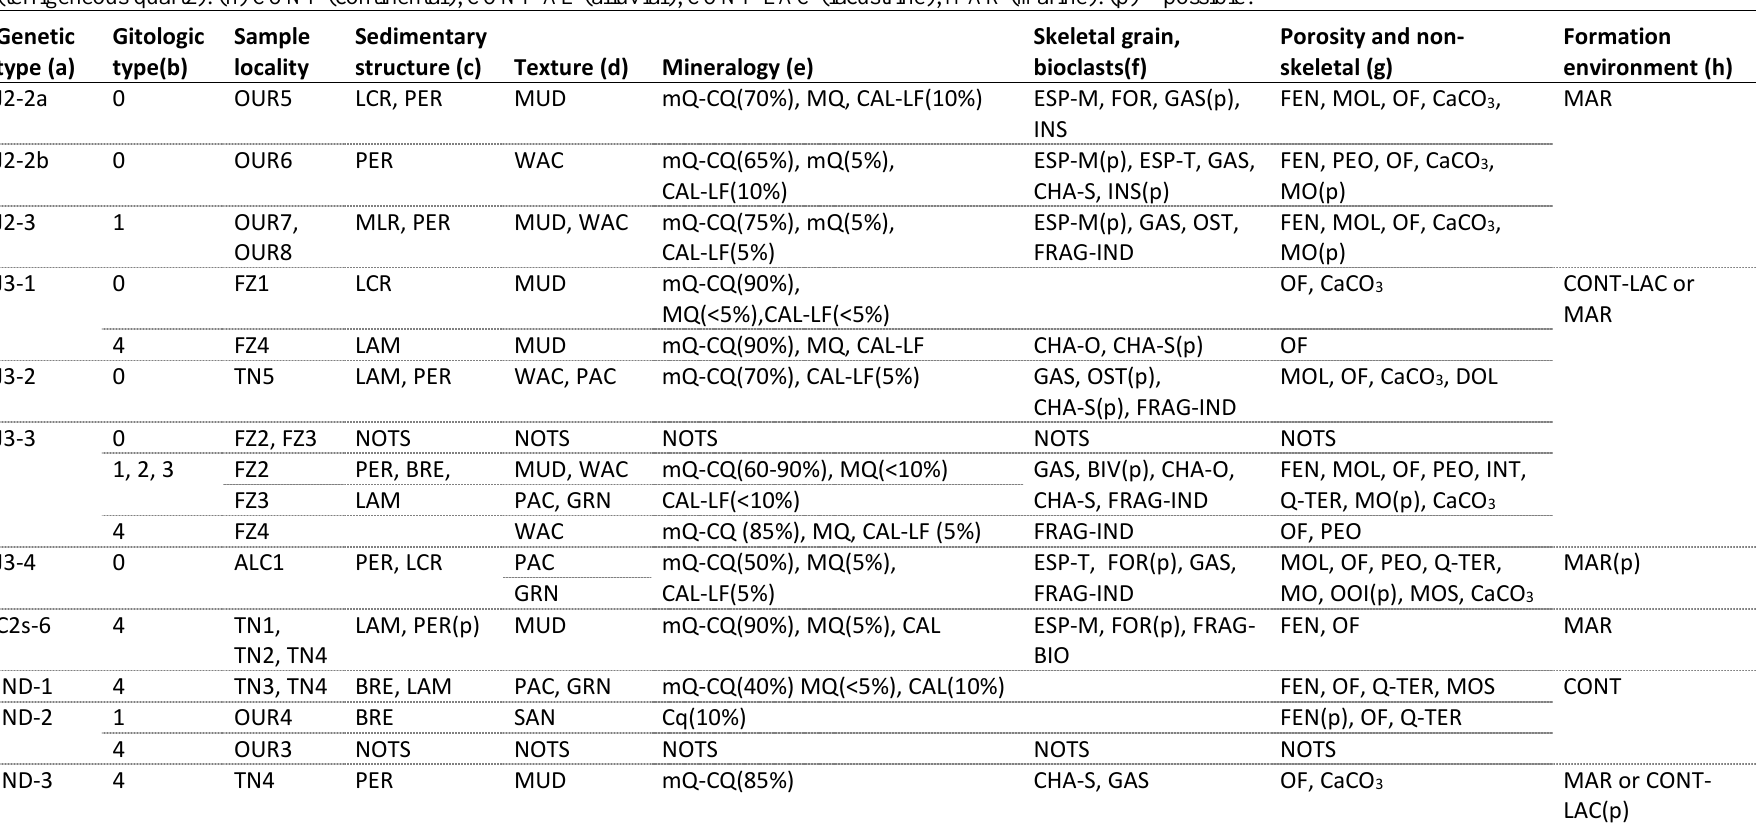
Table 1. Silicification types from CLM and TSB. (a) Types are named after geologic map codes followed by a sequential number. (b) 0 ( In situ outcrops), 1 (sub-primary outcrops), 2 (colluvial occurrence), 3 (recent river deposits), 4 (old alluvial deposits). (c) BRE (brechoidal), LAM (lamination), LCR (liesegang concentric rings), MLR (multiple liesegang rings), PER (peloidal relict). (d) CNG (conglomerate), GRN (grainstone), MUD (mudstone), PAC (packstone), SAN (sandstone), WAC (wackstone). (e) CAL (undetermined chalcedony), CAL-LF (chalcedony length-fast), CAL-LS (chalcedony length-slow), CQ (criptoquartz), mQ-CQ (microquartz-cryptoquartz), DOL (dolomite), MQ (macroquartz), mQ (microquarzt), Q (alpha-quartz). (f) BIV (bivalve), CHA-O (Charophyta gyrogonite), CHA-S (Charophyta stem), ESP-M (monoaxone spicule), ESP-T (triaxone spicule), FRAG-IND (Undetermined fragment). FOR (foraminifer), GAS (gastropod), INS (insertae sedis), OST (ostracod). (g) CaCO 3 (calcite), FEN (fenestral porosity), INT (intraclast), MO (organic material), MOL (moldic porosity), MOS (moscovite) OF (iron oxide), OOI (ooid), PEL (pellet), PEO (peloid), Q-TER (terrigeneous quartz). (h) CONT (continental), CONT-AL (alluvial), CONT-LAC (lacustrine), MAR (marine). (p) =